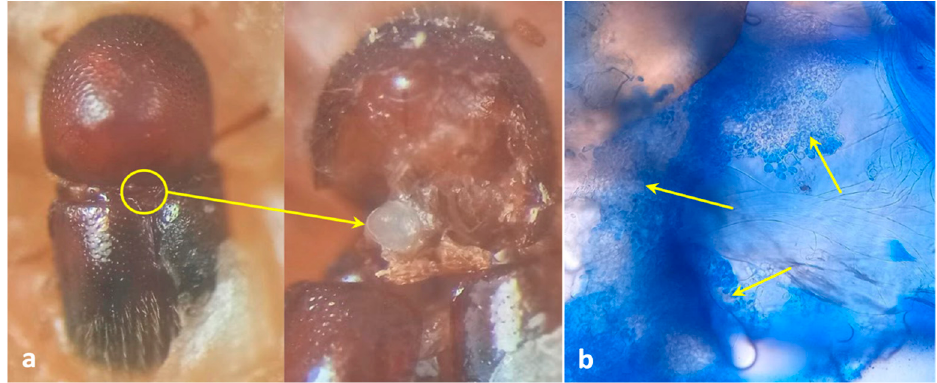
Figure 1. Mycangial dissection. ( a ) Location and view of mycangia; ( b ) view of symbionts harboring mycangia after staining with lactophenol cotton blue (arrows indicate the presence of fungal propagules inside mycangia).